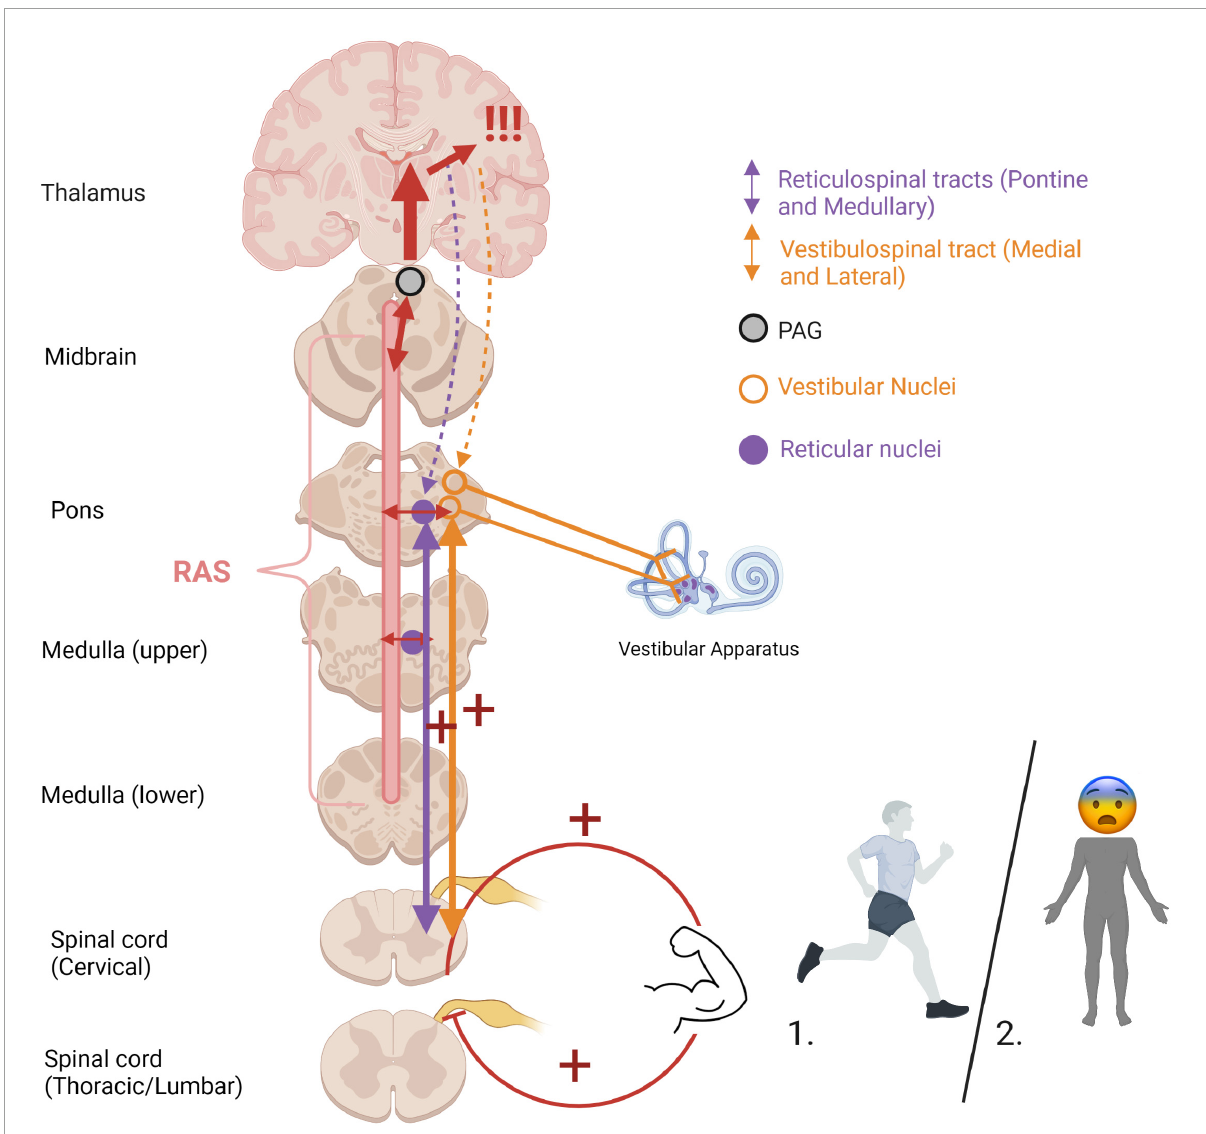
FIGURE6 Heightened muscle tonicity during fight/flight (1) and freeze/tonic immobility (2) responses. Overwhelm of subcortical arousal-affective circuitry (RAS and PAG) during traumatic stress cues heightened muscle tonicity, mediated by the vestibular and somatosensory systems. If the body carries out an active survival response, the system receives vestibular and somatosensory feedback from muscle engagement and bodily action. In situations of imminent danger, tonic immobility renders the body rigid, an evolutionarily primitive response to avoid predatory detection. Cortical structures are overaroused, and top-down modulatory influences are weakened (indicated by dashed lines), allowing for primitive brainstem and midbrain regions to dictate defensive responding and heightened muscle tonicity. If the body is prevented from carrying out defensive motor actions (i.e., fighting off, pushing away, running away), it may become pre-disposed to or “stuck” in this defensive posture post-traumatically. RAS, reticular activating system; PAG, periaqueductal